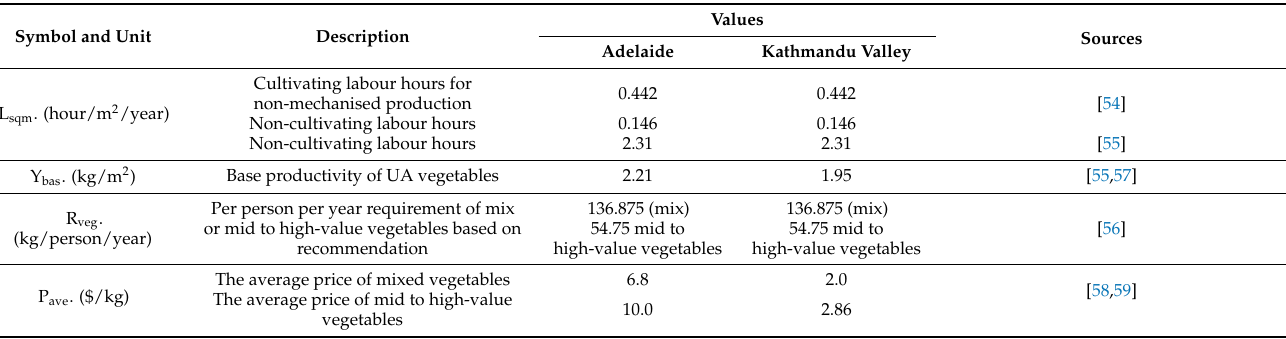
Table 1. Descriptions and list of values used in